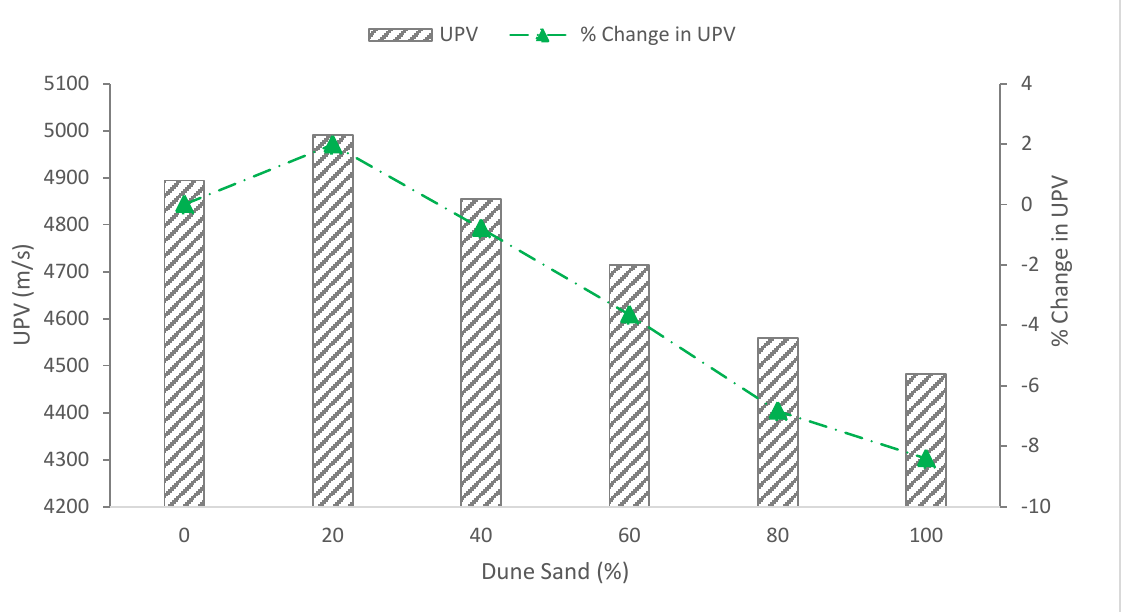
Figure 11. Ultrasonic pulse velocity (UPV): data source [40].